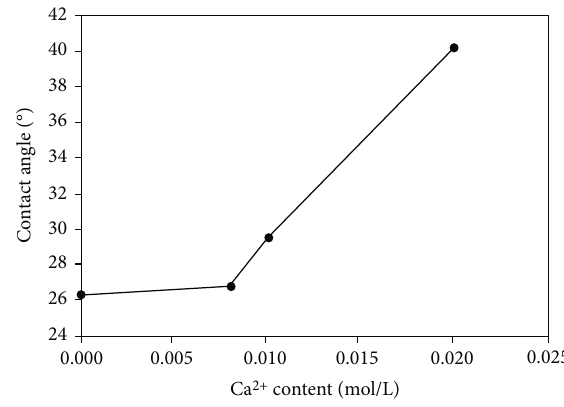
Figure 12: Relationship between Ca 2+ content and emulsion contact